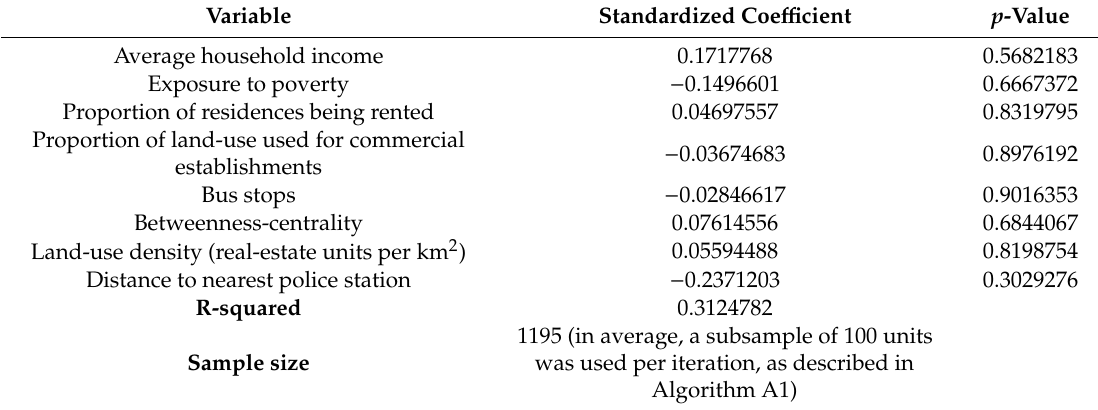
Table 6. Estimated model for burglary risk at residential apartments: Regressed coefficients and statistical significance of all variables used for a bandwidth of 9000 m (which provided the highest fitness score).